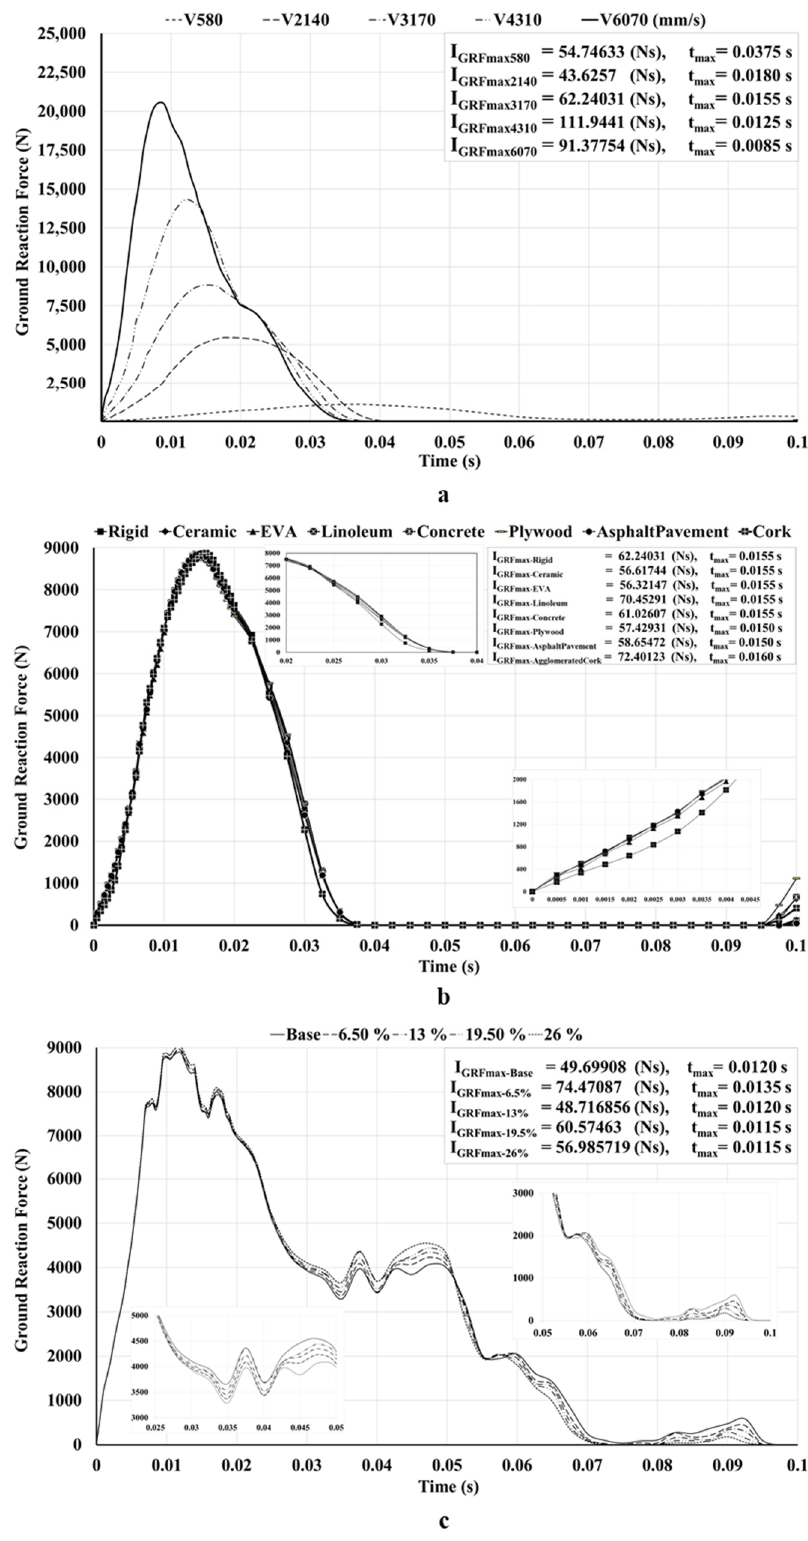
Figure 2. Ground reaction force: effect of ( a ) impact velocity; ( b ) flooring material; ( c ) trochanteric soft tissue (TST) stiffness.